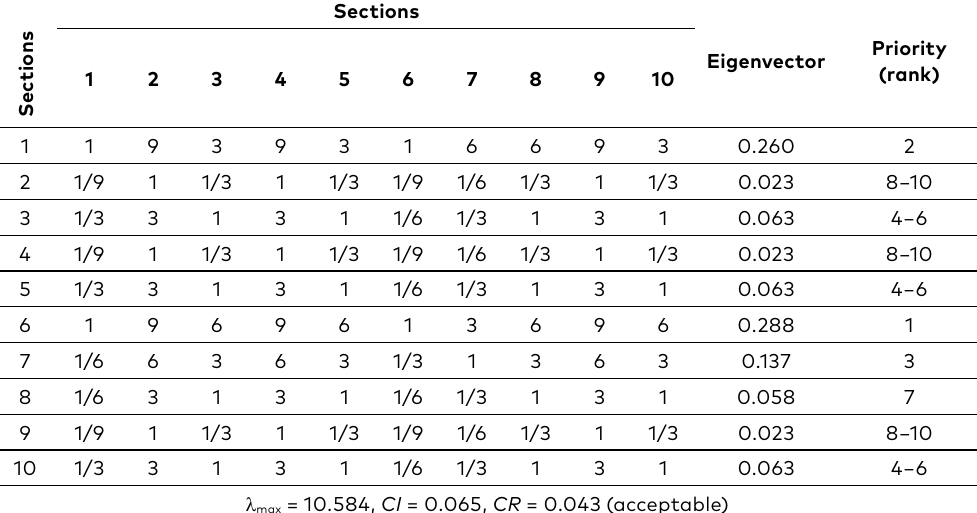
Table 6. Pairwise comparison of the accident sections